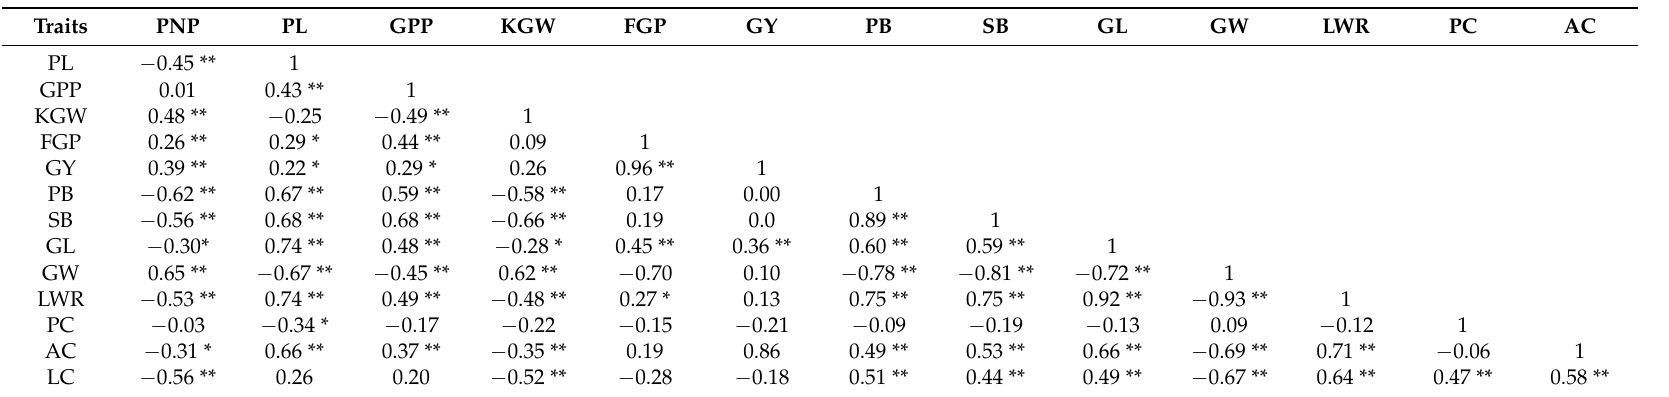
Table 3. Pearson correlation coefficients among phenotypic